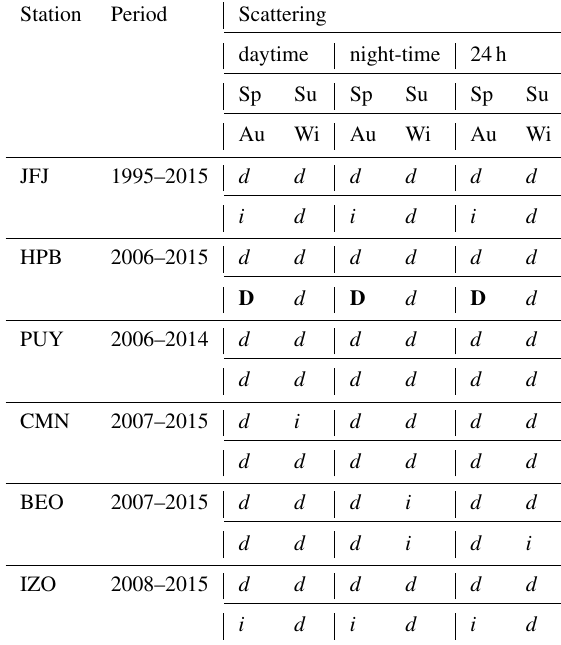
Table 3. Daytime (08:00 to 16:00GMT) and night-time (21:00 to 05:00GMT) σ sp trends by season calculated for the periods con- sidered in this work. Sp is spring, Su is summer, Au is autumn and Wi is winter. Trends are considered statistically significant at a p value of < 0.05. Statistically significant increasing or decreas- ing trends are highlighted with capital bold I and D letters. Non- statistically significant increasing or decreasing trends are high- lighted with lower case italic i and d letters.